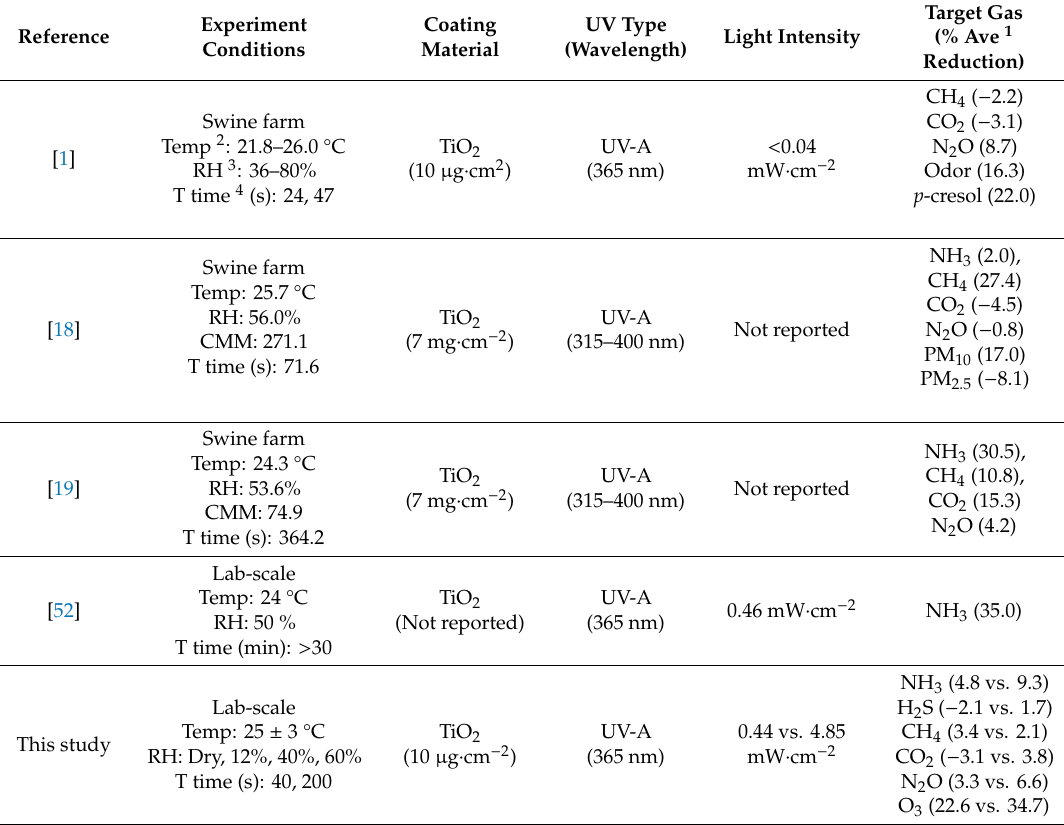
Table 6. Summary of mitigation for selected target gas in photocatalysis with